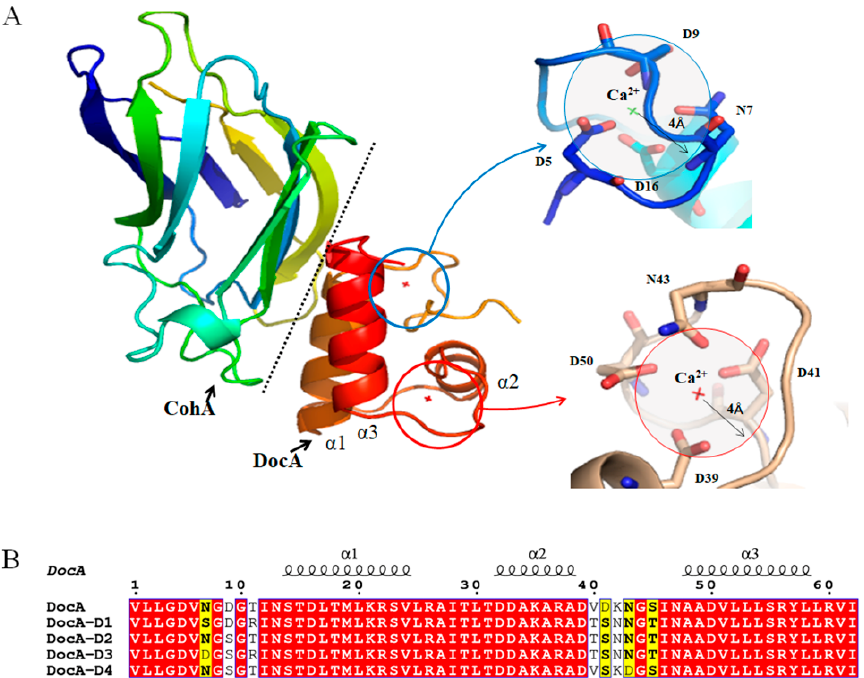
Figure 1. Coh and DocA mutation strategy. ( A ) The structure of the Coh–DocA complex and the mutation design of Ca 2+ binding key amino acid. ( B ) Alignment of protein sequence of docking protein DocA mutants.